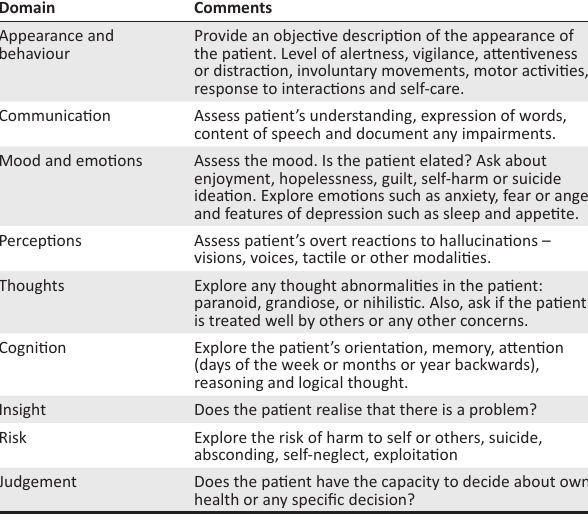
TABLE 2: Mental state